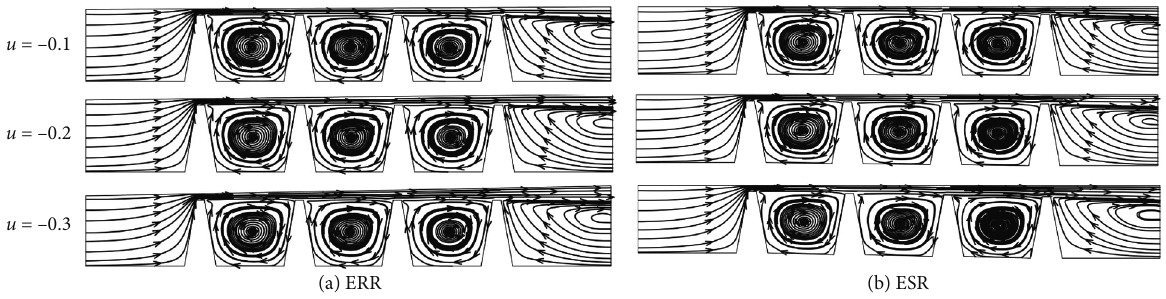
= 0 : 23 , and C = 0 : 067 U